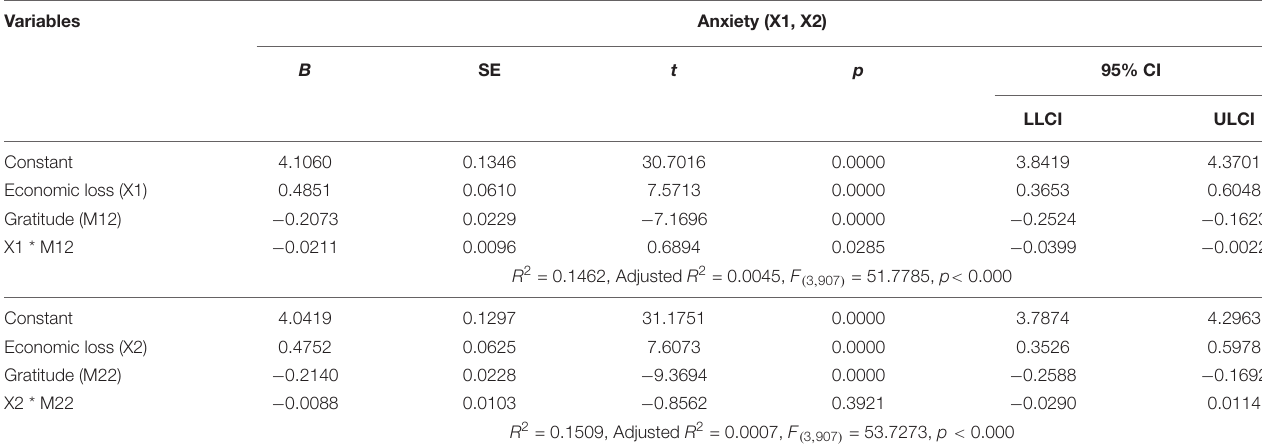
TABLE 5 | The moderating effects of gratitude on the relationship between economic loss and anxiety.